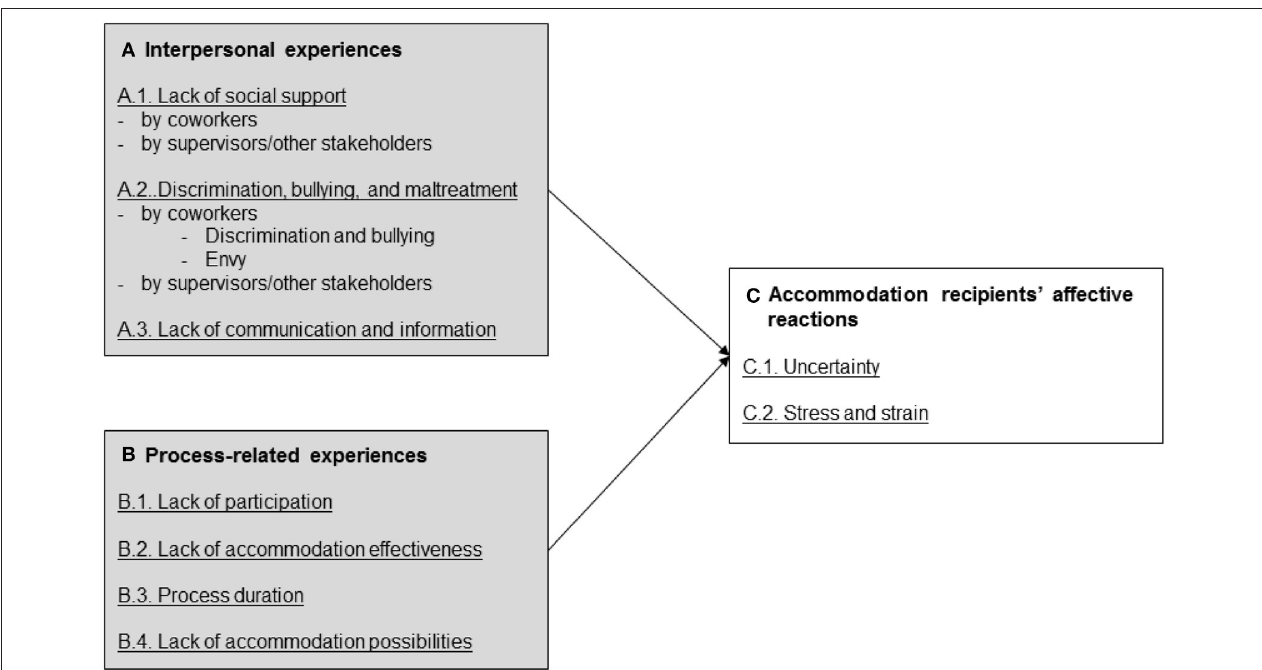
FIGURE 1 | Model of negative experiences during the accommodation